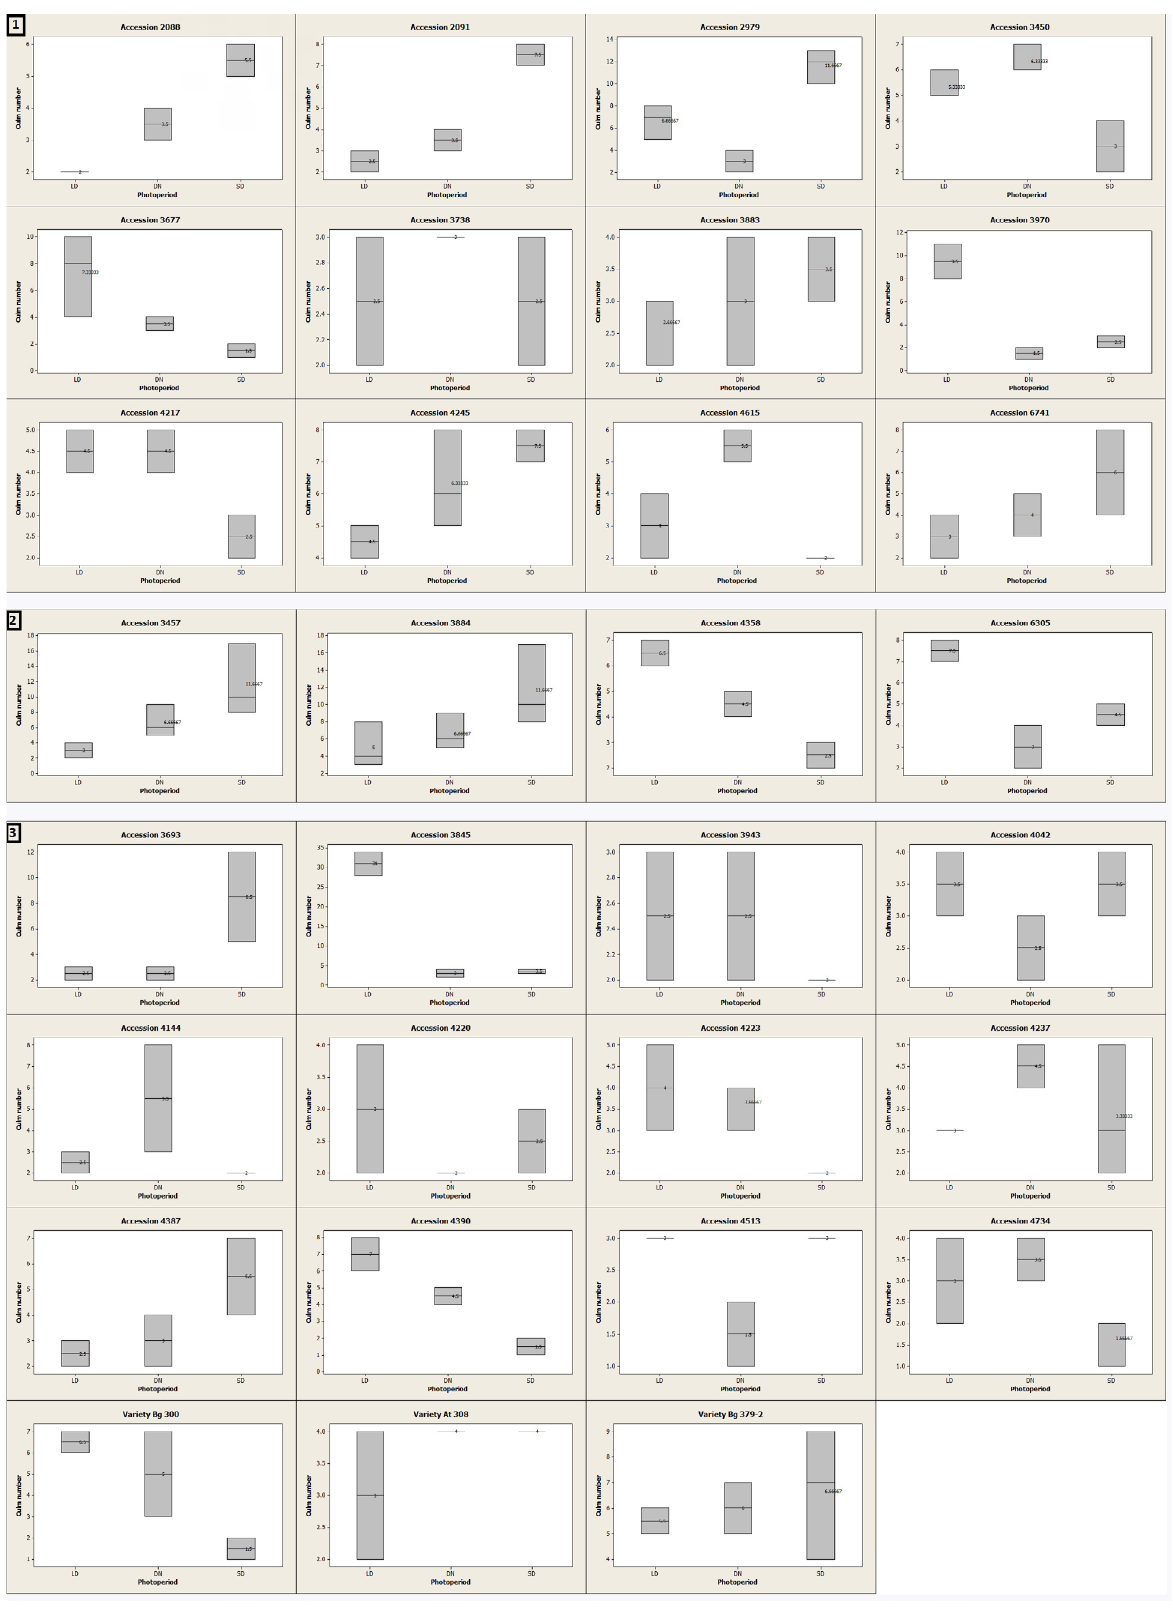
Figure 2: Effect of photoperiod on culm number variation among Sri Lankan very early maturing rice accessions: 1) that flowered early under LD condition; 2) that flowered early under DN condition; 3) that flowered early under SD